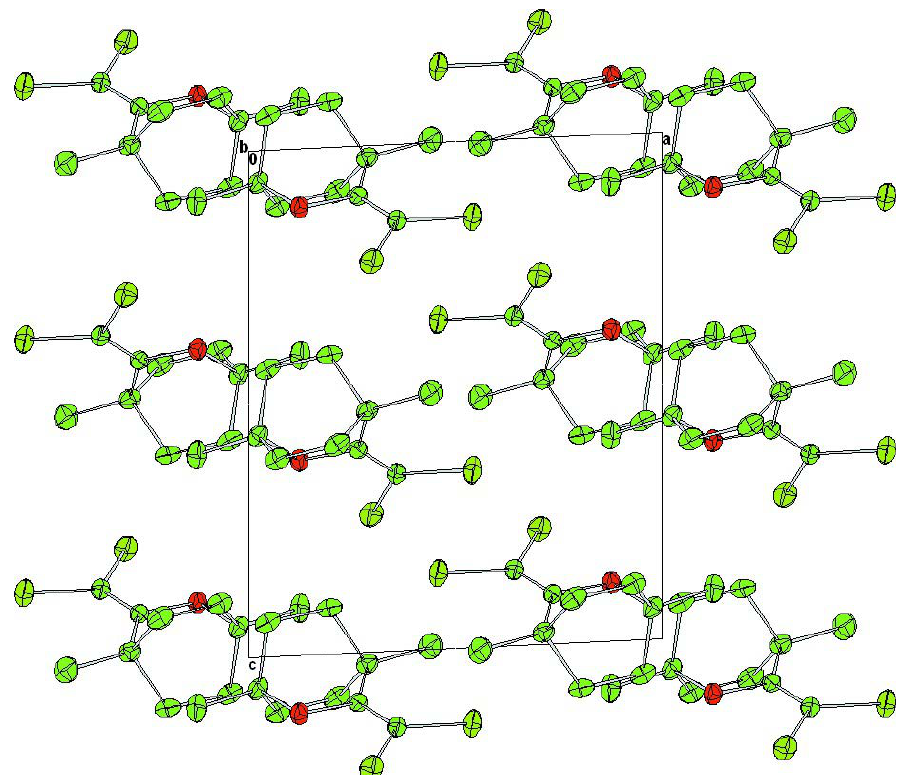
The title compound viewed along the b -axis with H atoms